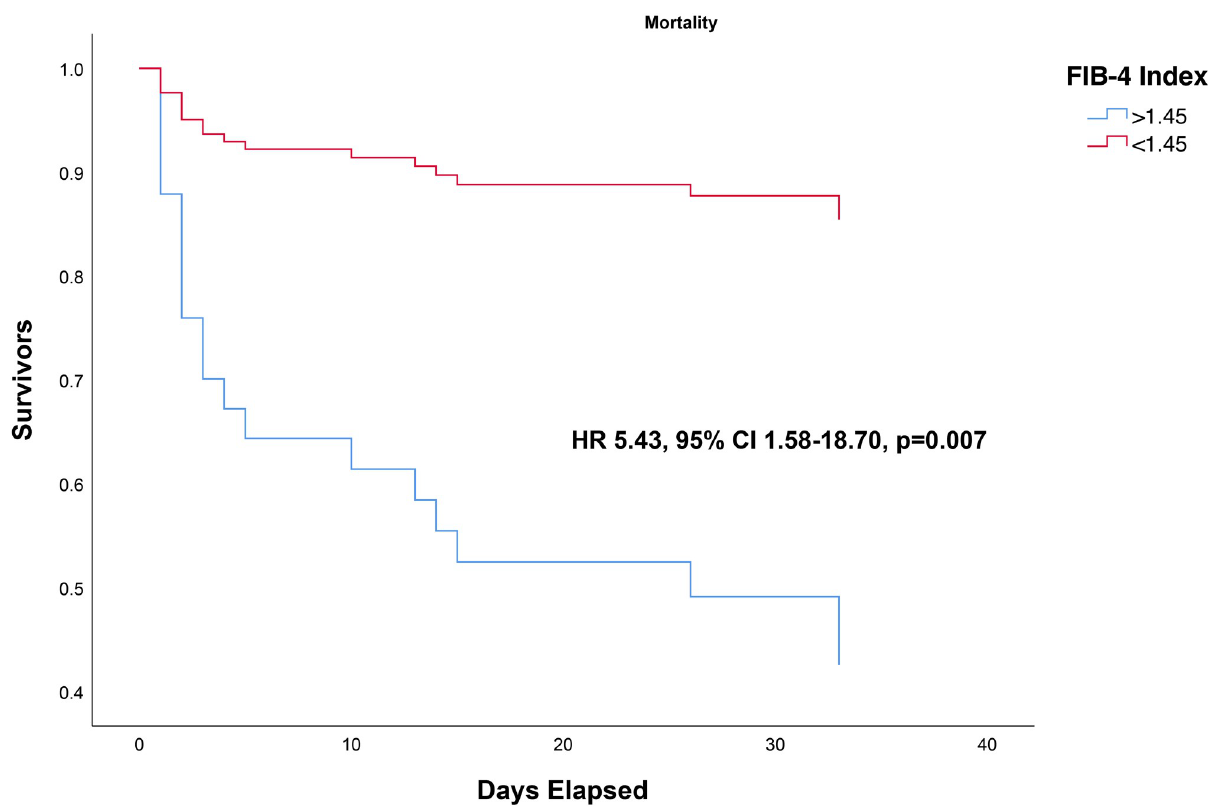
Fig 5. Time-to-event analysis for FIB-4 > 1.45 and mortality (3-months survival). All of the events occurred at or before the 34 th day.